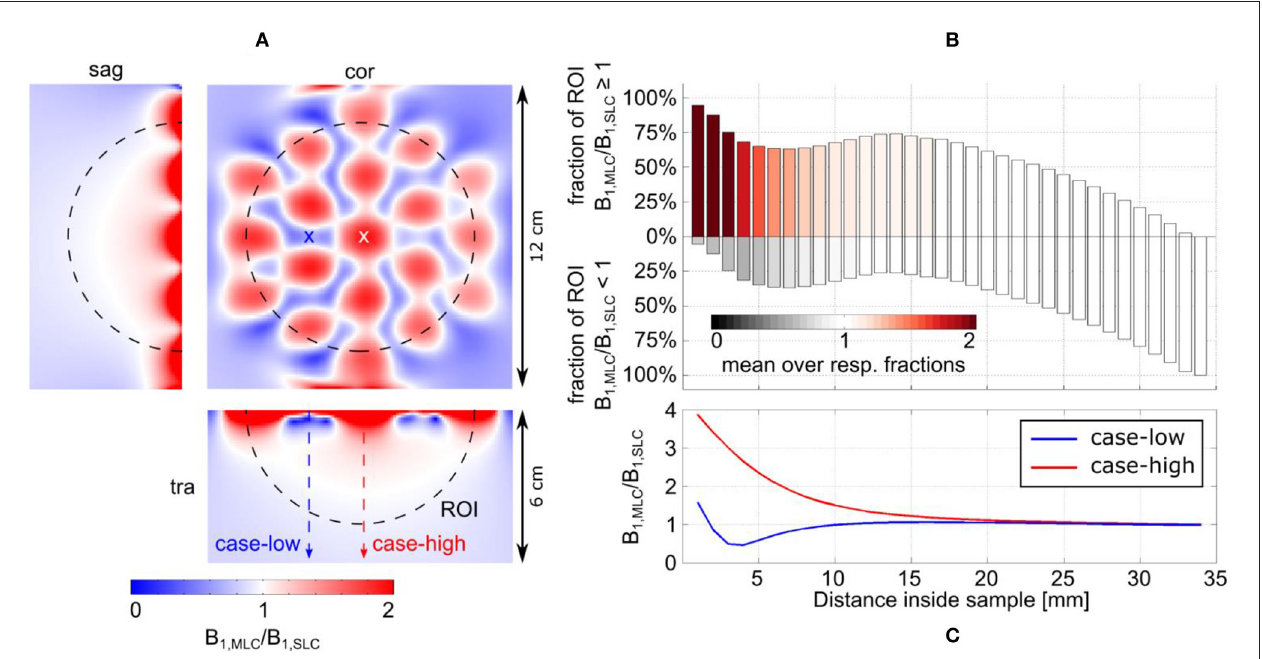
FIGURE 6 | Detailed analysis of the transmit efficiency ratio between MLC and SLC at 3T. (A) Ratio maps in the central sagittal and transversal slice as well as a coronal slice in a depth of 7mm. (B) Analysis of the ratio in the ROI shown by the dashed black line in (A) . The position of the bars along the y-axis shows the fractions of the ROI for which either the MLC or the SLC have higher transmit efficiency. The color of the bars indicates how much the ratio in the respective fractions deviates from 1; i.e., white indicates comparable performance (1 5%). (C) Line profiles parallel to the coil axis for locations of high (red dashed line and white cross, ± “case-high”) and low (blue dashed line and cross, “case-low”) B 1 intensity of the